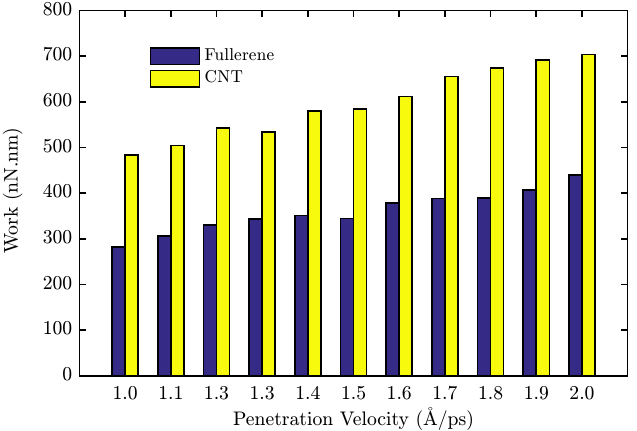
Figure 6. Work w required to pull fullerene and end-capped CNT through the cell membrane, for various pulling